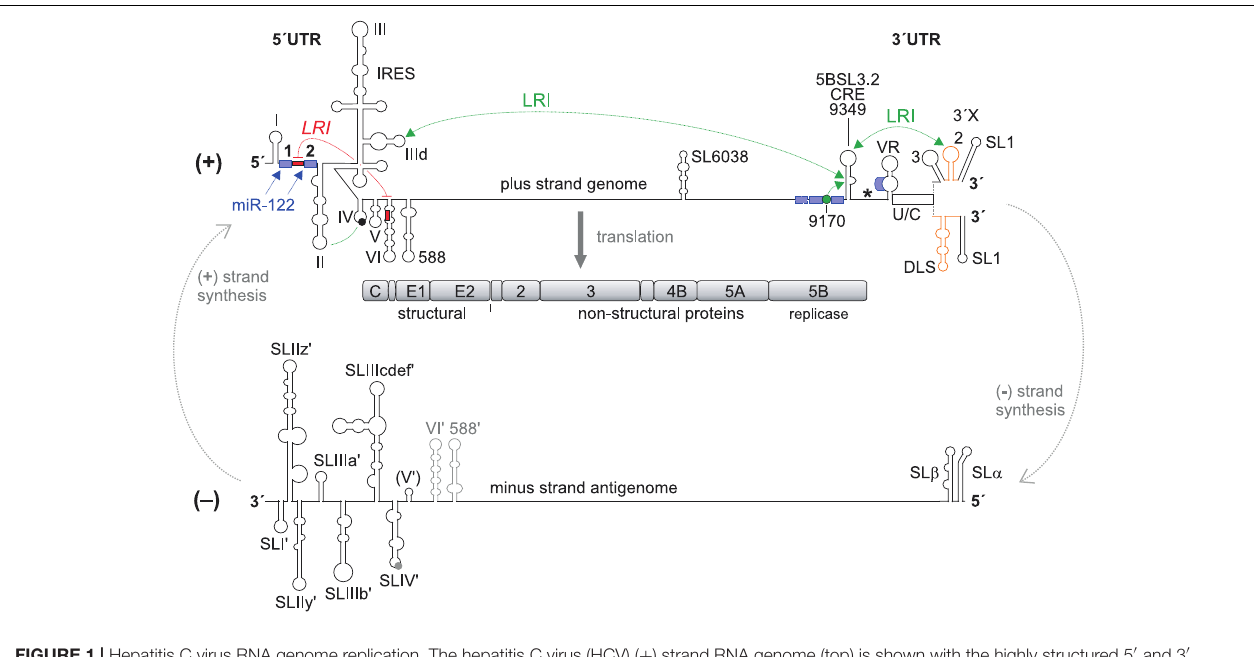
FIGURE 1 | Hepatitis C virus RNA genome replication. The hepatitis C virus (HCV) ( + ) strand RNA genome (top) is shown with the highly structured 5 (cid:48) and 3 (cid:48) untranslated regions (UTRs) and additional RNA secondary structures as mentioned in the main text. The polyprotein start codon AUG is shown as filled circle in stem-loop (SL) IV of the IRES, the polyprotein stop codon as asterisk. The polyprotein is co- and post-translationally processed into the mature structural and non-structural (NS) proteins. The NS3-NS5B proteins form the replication complex with the NS5B protein as the viral RNA dependent RNA polymerase (RdRP, replicase). Stimulatory (green) and inhibitory (red) long-range RNA-RNA interactions (LRIs) and binding sites for the liver-specific microRNA-122 (miR-122) (blue boxes) are shown. The HCV genome replicates by producing a minus strand (-) antigenome (bottom), which in turn is used as the template for progeny plus strand production. RNA secondary structures are named as in the main text. CRE, cis -replication element, DLS, dimerization linkage sequence; IRES, internal ribosome entry site; U/C, poly(U/C) tract; VR, variable region. The drawings of the RNA secondary structures are not to scale in relation to genome length.